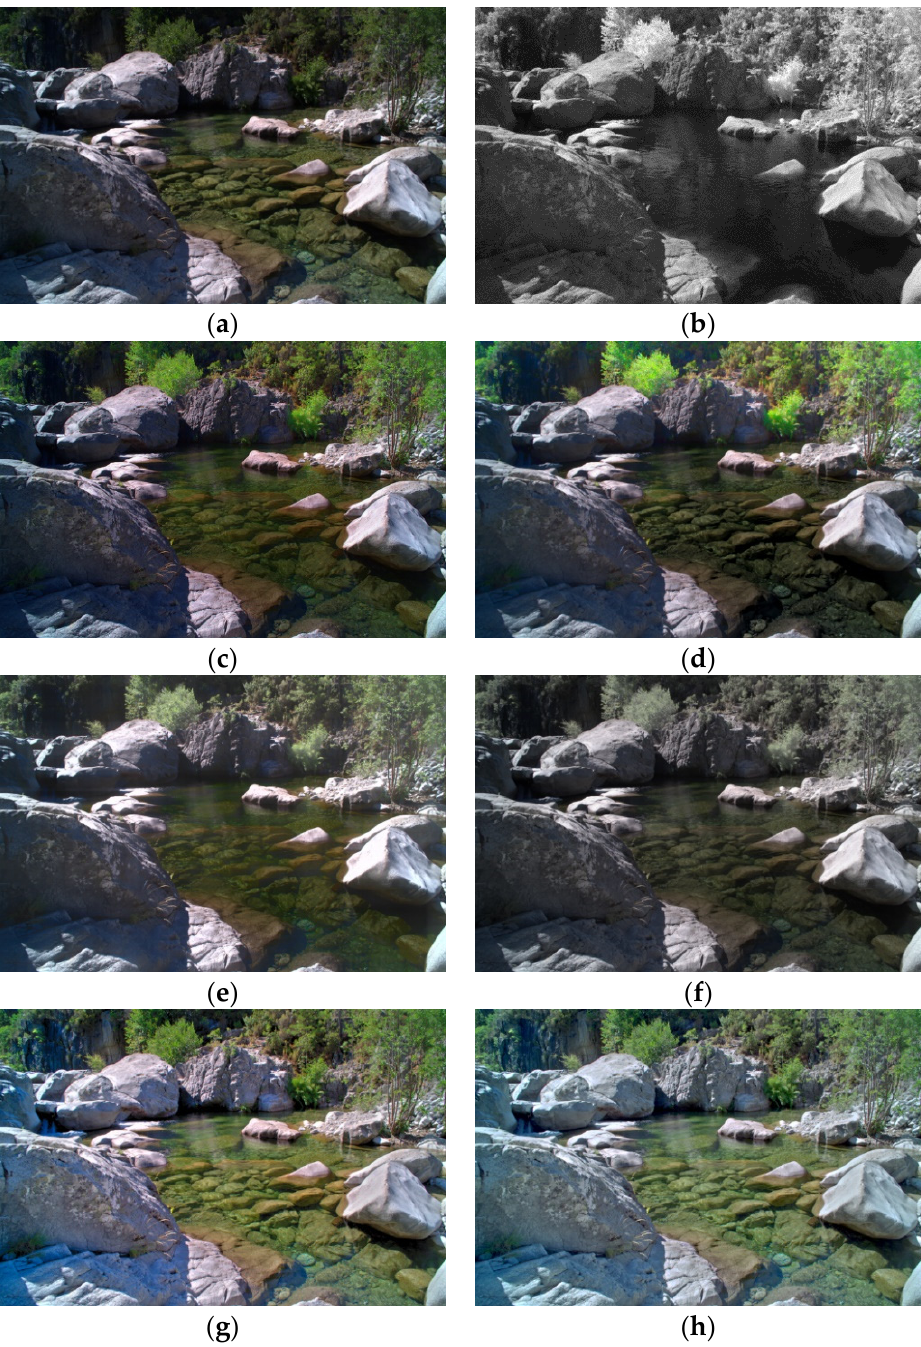
Figure 10. Input pair and result images: ( a ) visible image; ( b ) IR image; ( c ) Laplacian pyramid entropy fusion; ( d ) Laplacian pyramid PCA fusion; ( e ) low-rank fusion; ( f ) dense fusion; ( g ) proposed method (luminance channel fusion); and ( h ) proposed method (XYZ channel fusion).